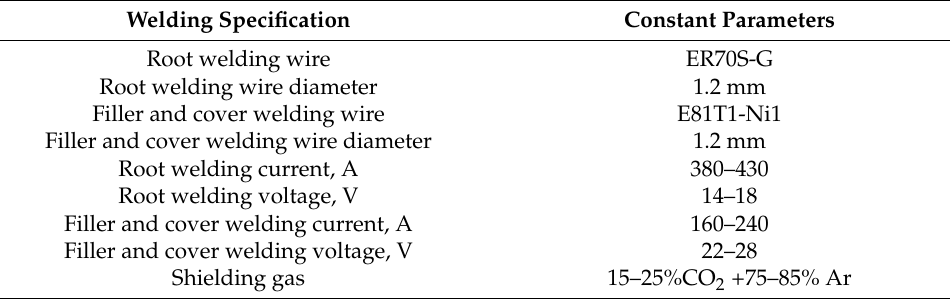
Table 1. Welding specifications and constant